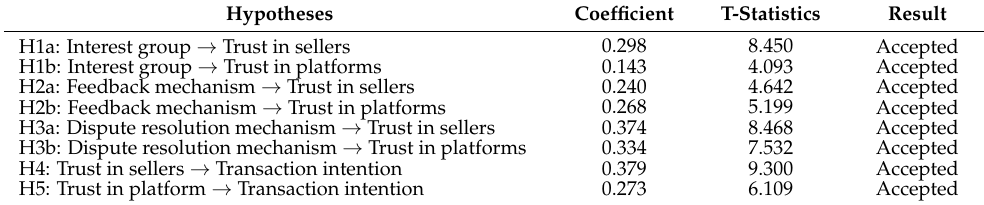
Table 4. Structural model